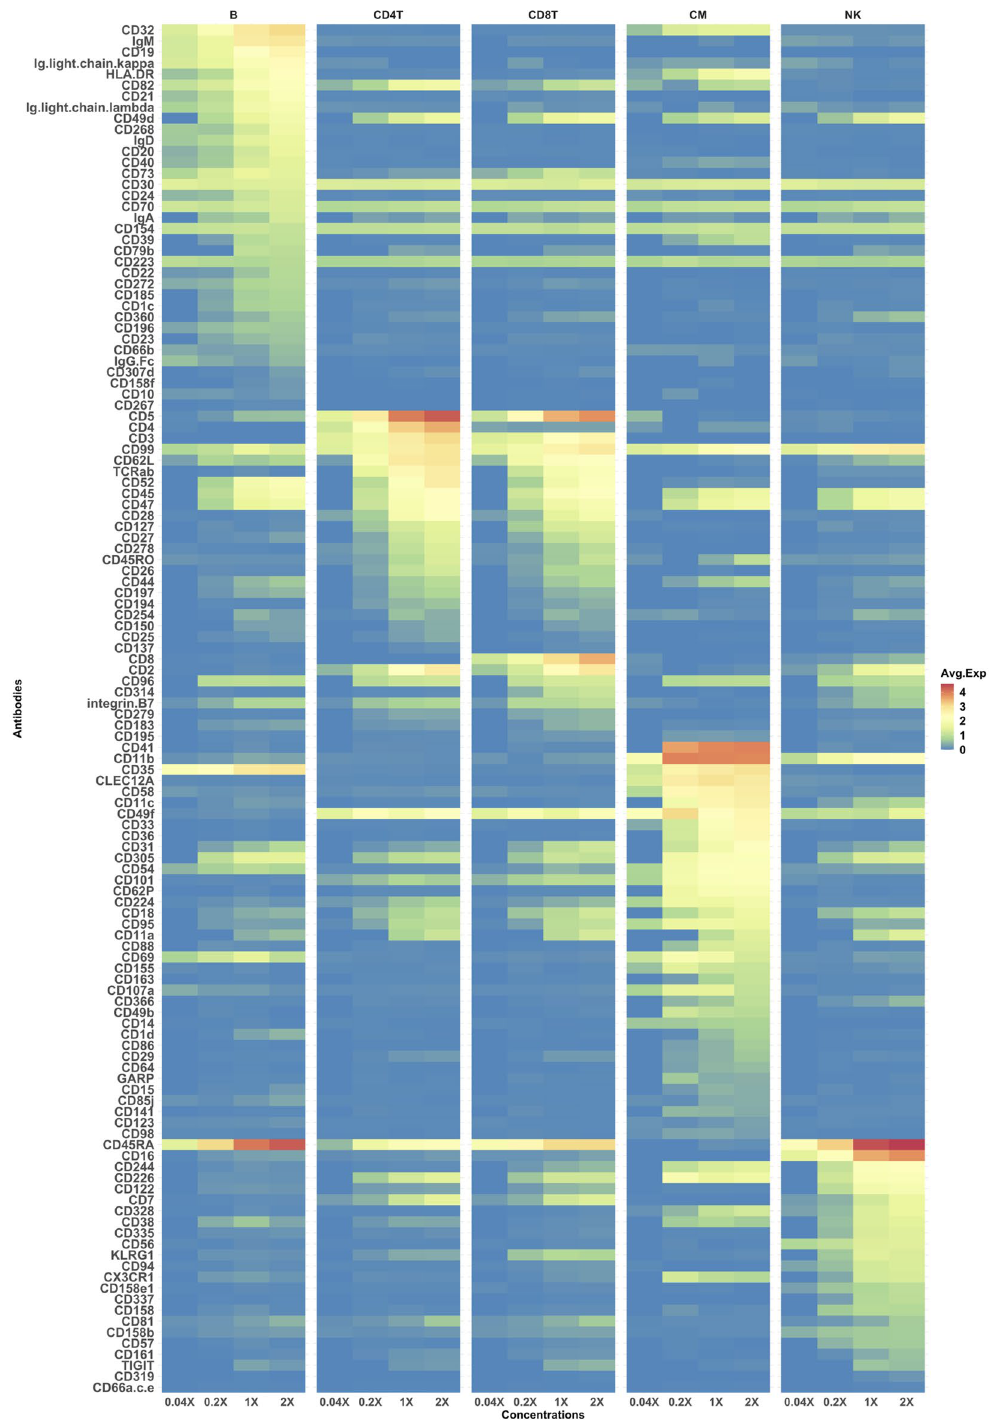
Figure 6. Dose-responses of all thresholded antibodies. Centered log-ratio (CLR) normalized expression levels in all cell types and at all antibody concentrations are displayed as a colored heatmap. Antibodies are clustered depending on the cell type in which the expression was highest (from top to bottom: B cells, CD4 T cells, CD8 T cells, Classical Monocytes (CM), and natural killer (NK)